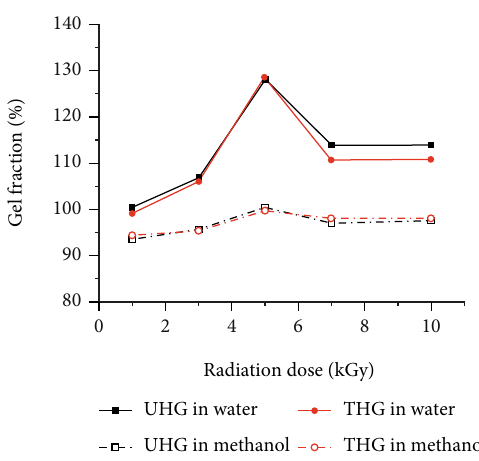
Figure 3: Gel fraction of THG and UHG in water and